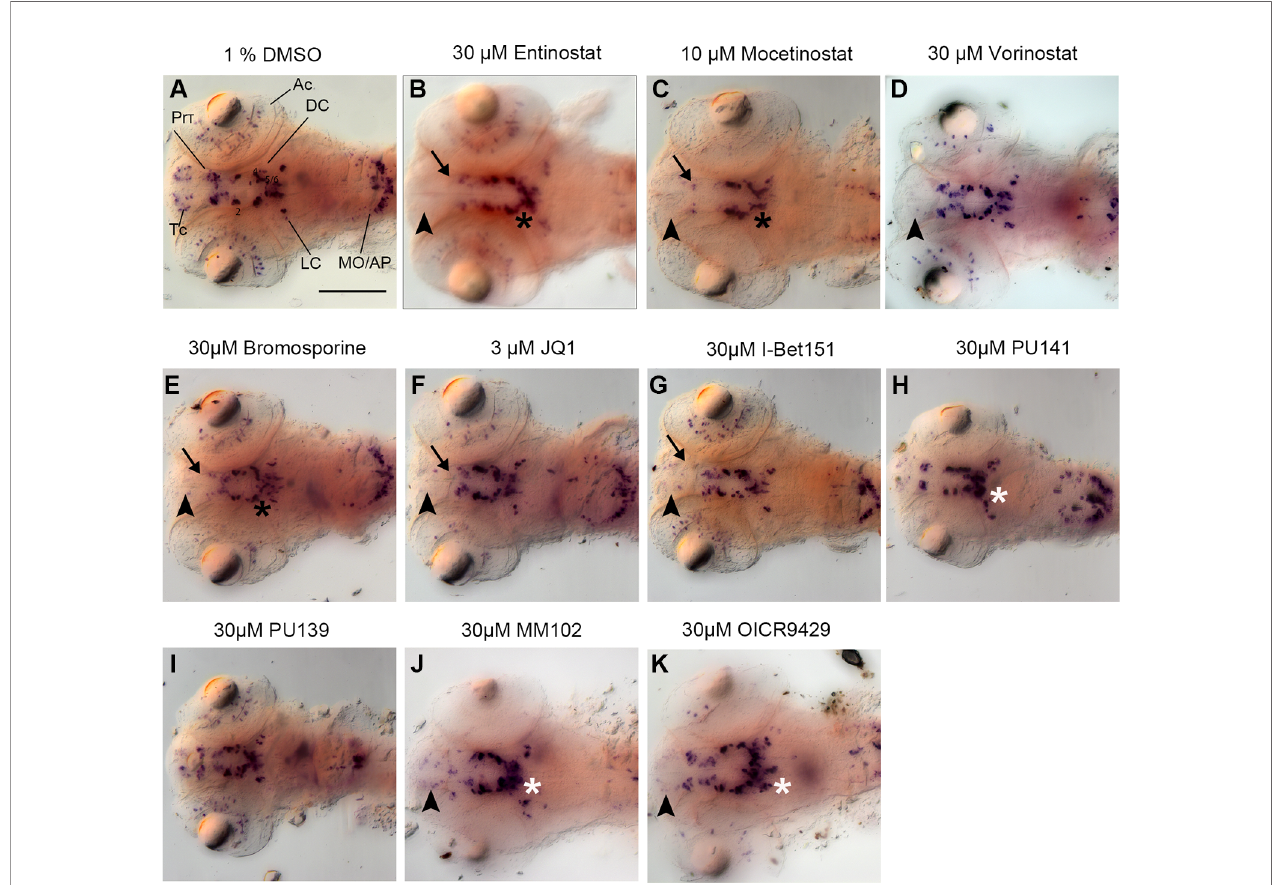
FIGURE 3 | Primary Screen results for representative small molecule inhibitors. (A – K) Expression of the DA and NA neuronal marker th detected by whole mount in situ hybridization in embryos fi xed after drug or control treatment at 96 hpf. Treatments are indicated above each panel. During the primary screen th expression was analyzed in DA clusters in telencephalon, pretectum, and diencephalic groups 1 – 6. Dorsal views of heads of larvae, images generated from Z-Projections of image stacks. Neuronal groups with reduced WISH stain are indicated as follows: Black arrowheads for telencephalic DA clusters (B – G, J, K) , black arrows for pretectal DC clusters (B, C, E – G) , black asterisks for DC DA clusters (B, C, E) . White asterisks indicate increased stain intensities in DC DA clusters (H – K) . Scale bar in (A) is 100 µm for all panels. AC, amacrine cells; Tc, telencephalon; PrT, pretectum; DC, diencephalic groups; Lc, locus coeruleus; MO/AP, medulla oblongata/area